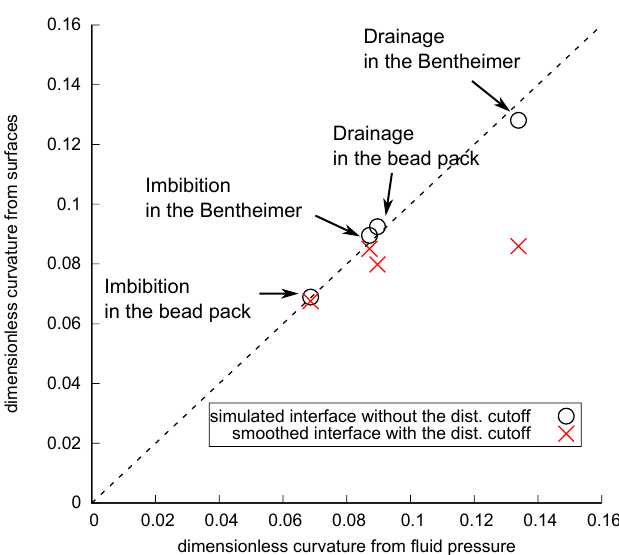
dimensionless curvature from fluid Figure 15. Comparison between the curvature obtained from the average capillary pressure in the porous domain and that obtained from the average curvatures on fluid interfaces after drainage and imbibition for the bead pack and Bentheimer sandstone. The circles show the average value of the computed curvatures on the simulated interfaces without the distance cutoff (see Figures 13b and 14b), while crosses show that computed on the smoothed interface with the distance cutoff (see Figures 13a and